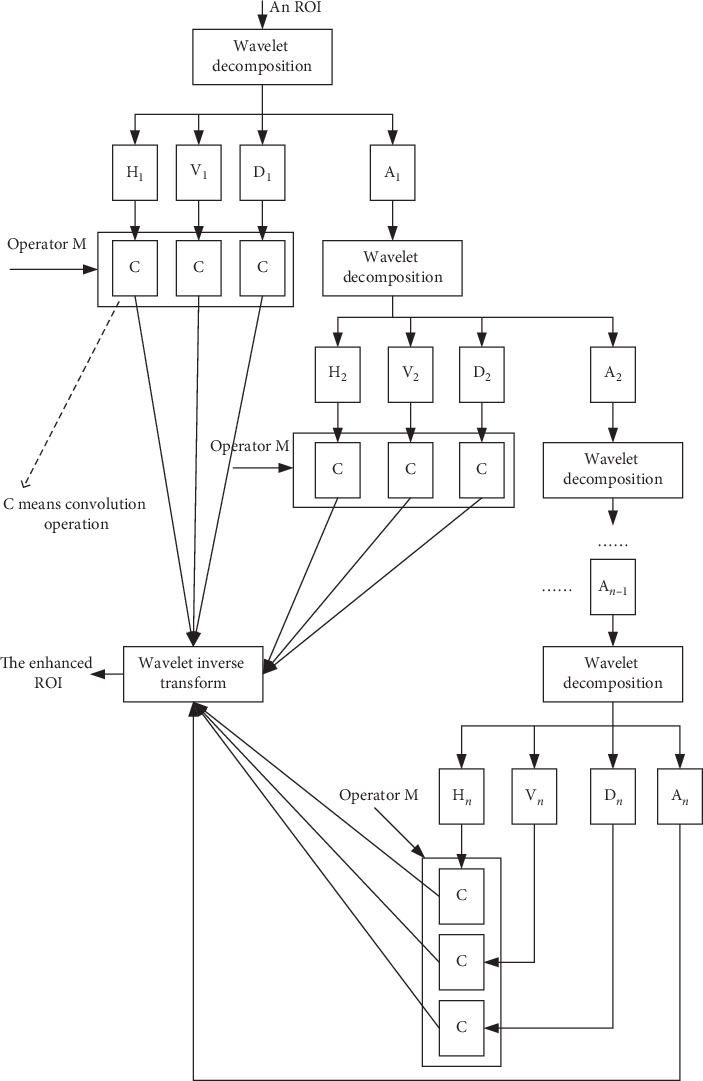
Processes of WF.